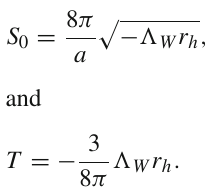
ByusingtheEq.(15)onecanobtaintheentropyandHawking